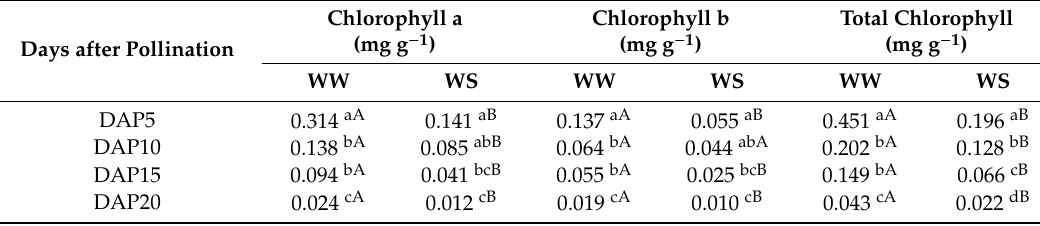
Table 1. Effect of drought stress on the concentration of chlorophyll in the pod wall. Table 1. E ff ect of drought stress on the concentration of chlorophyll in the pod wall.